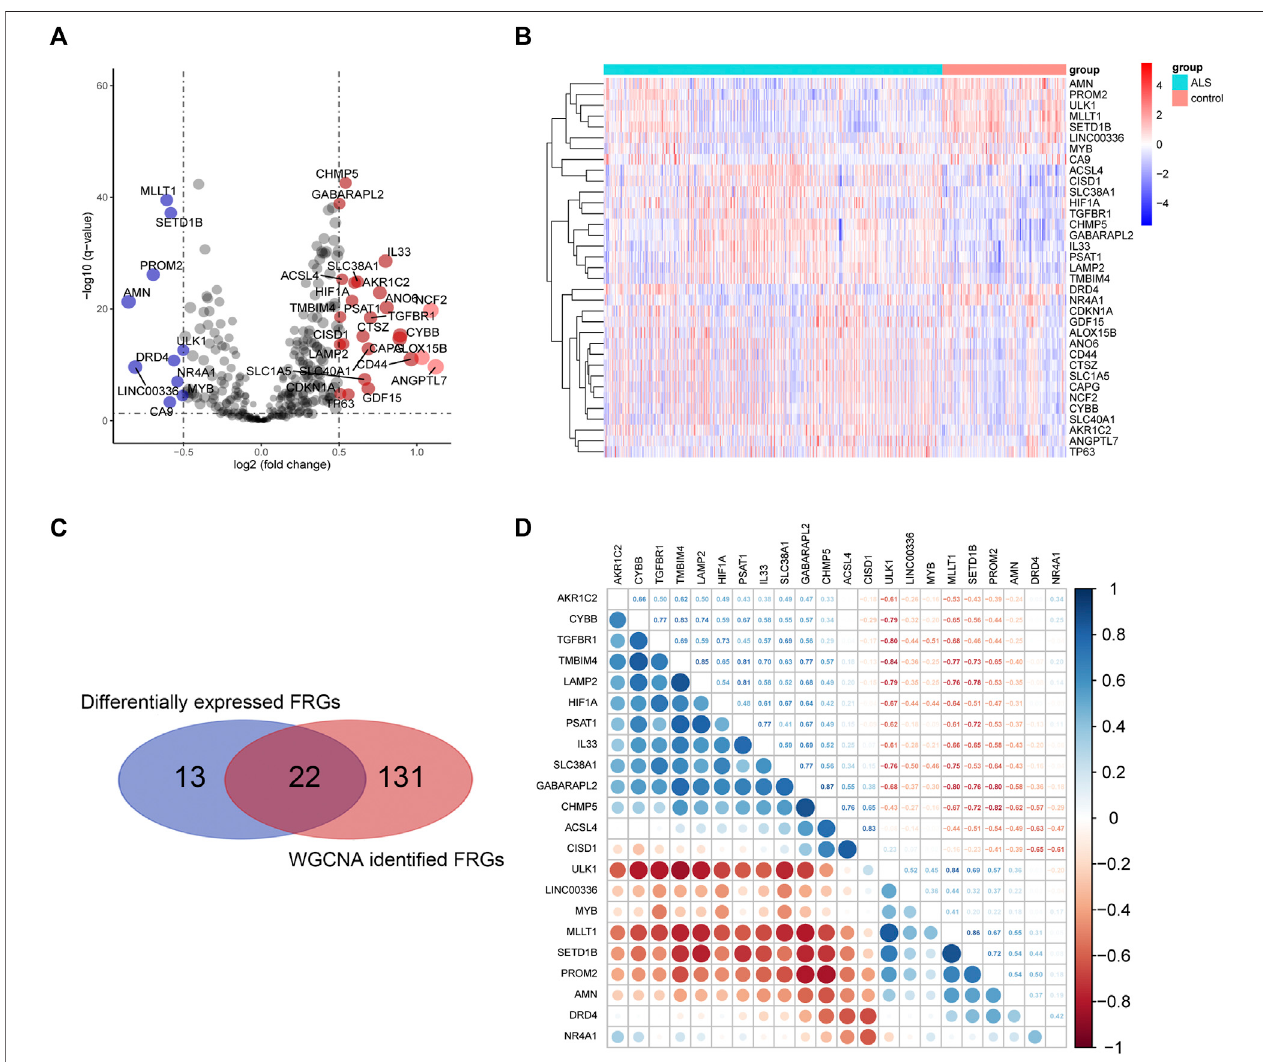
FIGURE 5 | Overlapping differentially expressed FRGs and ALS-related FRGs derived from WGCNA. (A) and (B) represent the volcano plot and heat map of differential FRG expression analysis. (C) Twenty-two overlapping genes were identi fi ed between differentially expressed FRGs and ALS-related FRGs derived from WGCNA. (D) Heatmap of Pearson ’ s correlation across 22 overlapping genes. Abbreviations: ALS, amyotrophic lateral sclerosis; WGCNA, weighted gene correlation network analysis; FRGs, ferroptosis-related genes.